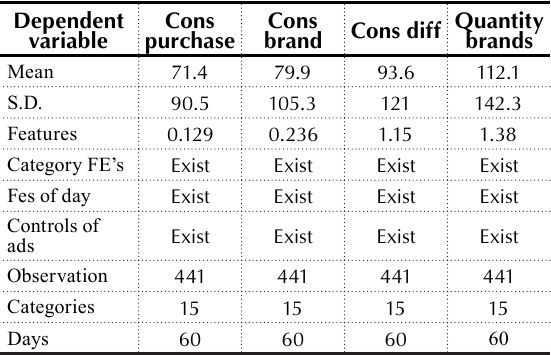
Table 3. The effects of ads on